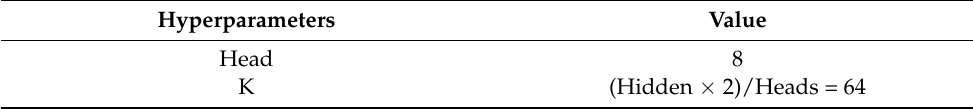
Table 3. Hyperparameters of Multi-Head Self Attention Structure.